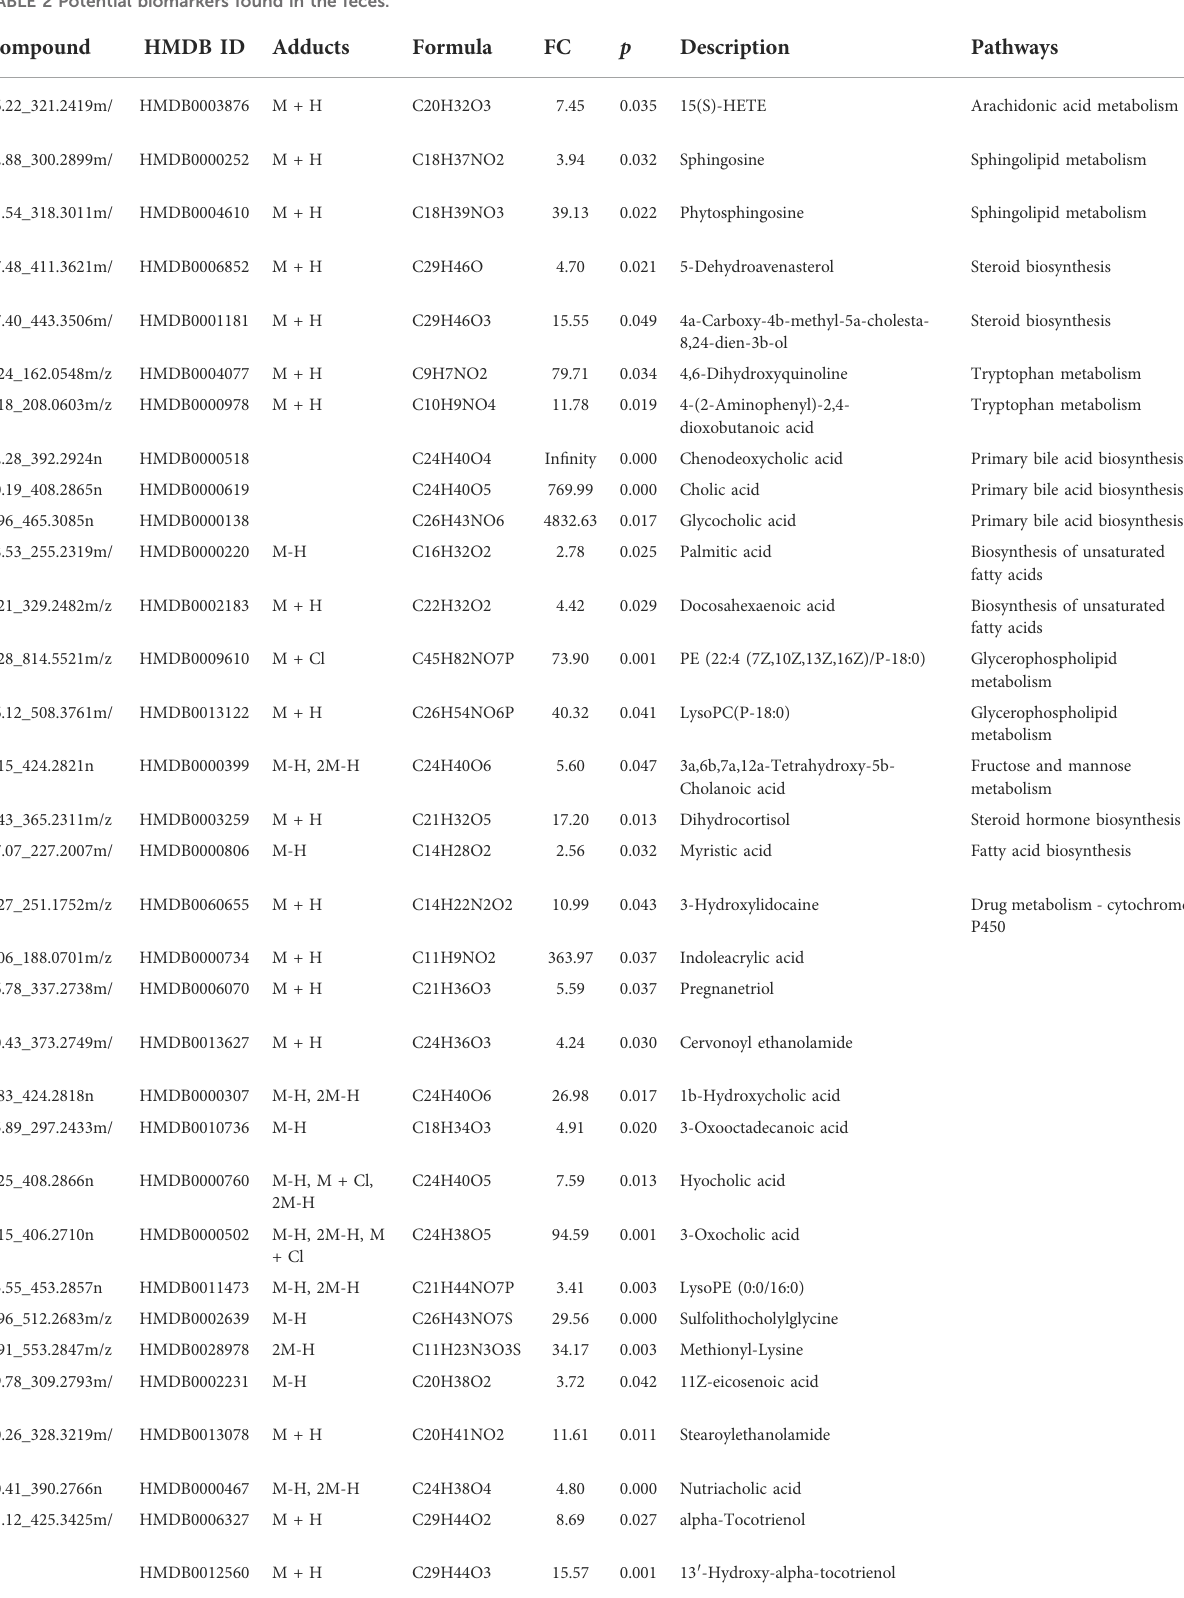
TABLE 2 Potential biomarkers found in the